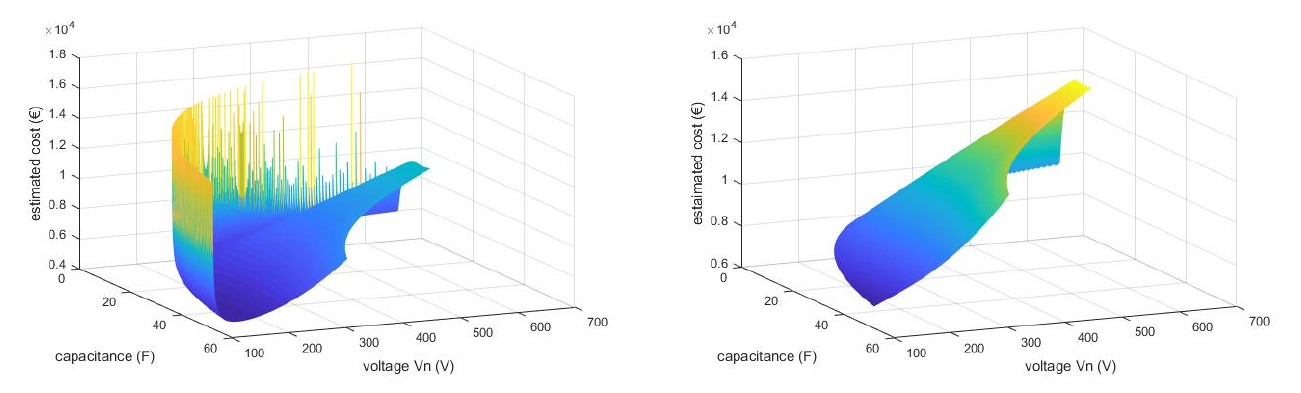
Figure 6. Estimated overall cost considering the SCM and the SCC for ( a ) non-isolated converter and ( b ) isolated